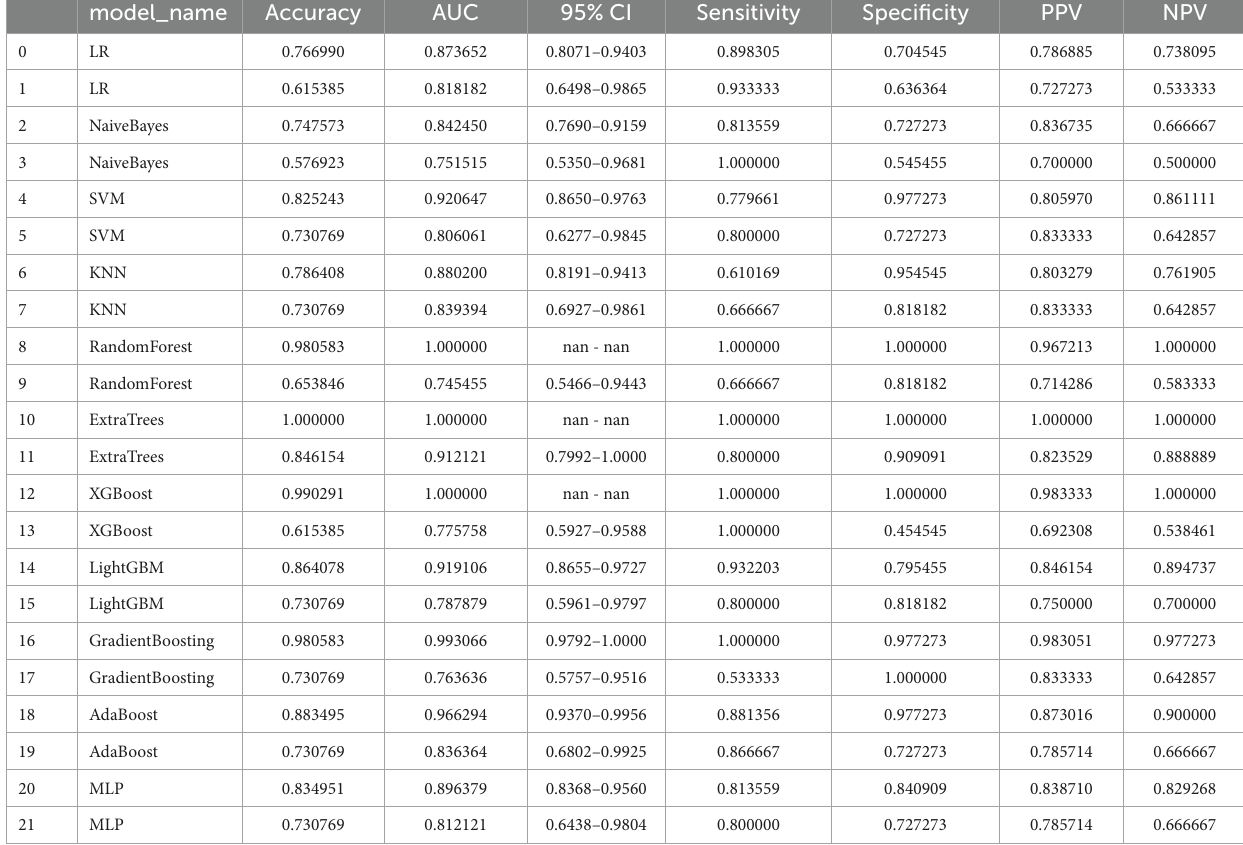
TABLE 2 Average performance of different machine learning models on train cohort (even rows) and test cohort (odd